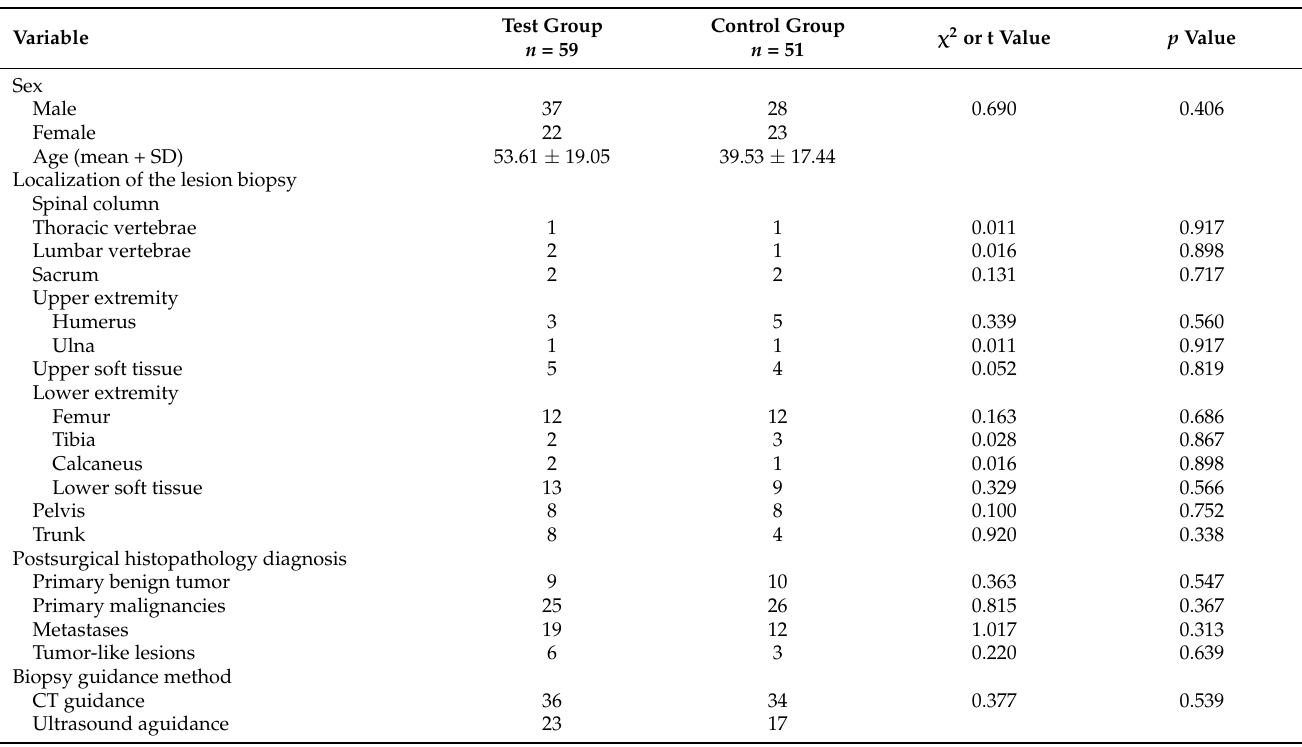
Table 1. Comparison of the baseline clinical characteristics of the patients in the test and control groups.